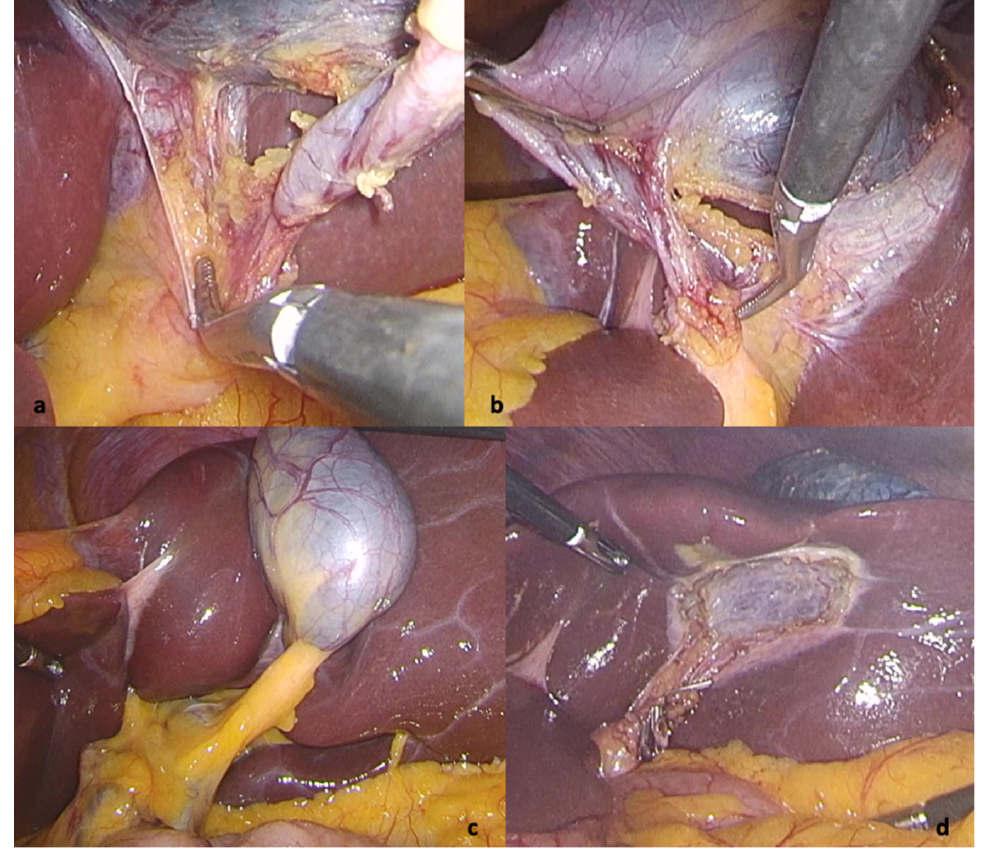
Figure 3. Intraoperative view: ( a ) critical view of safety ( b ) lateral to medial view of the cystic duct ( c ) view of the Calot region at the beginning of surgery ( d ) view after successful cholecystectomy. Postoperative pathological examination confirmed the presence of gallstones with chronic cholecystitis. No abnormalities were observed at the 30-day